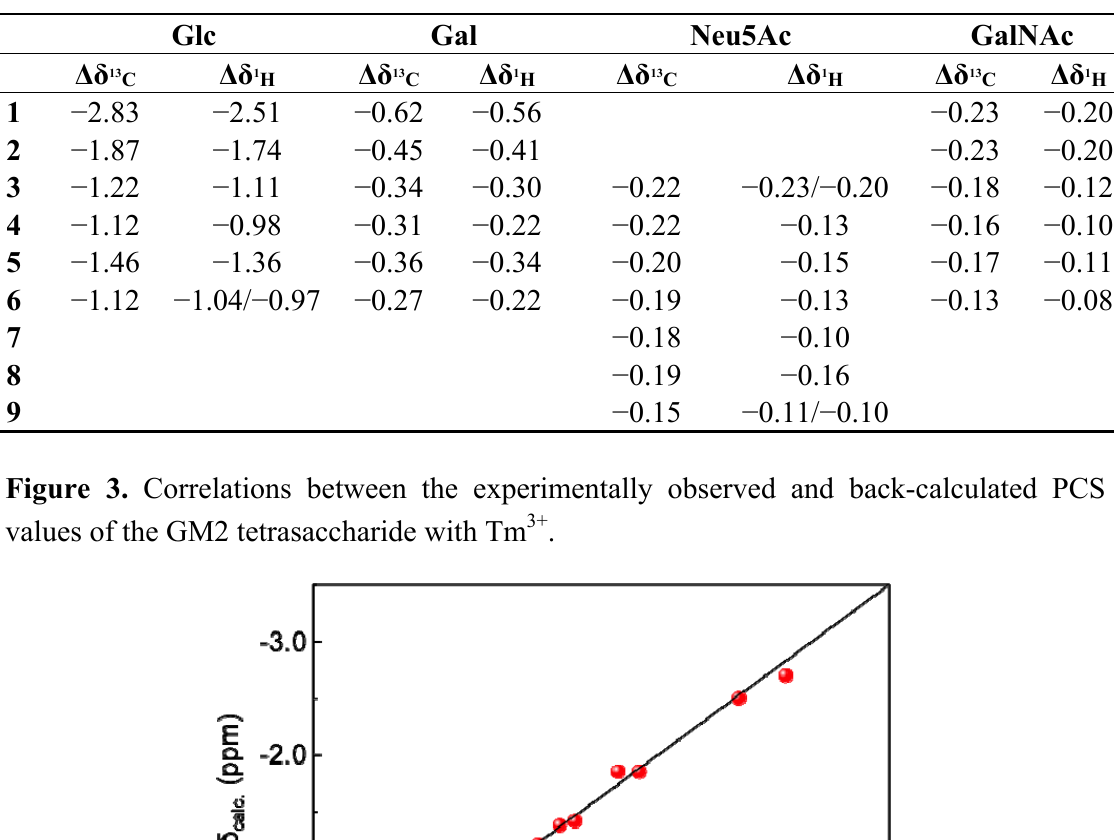
Table 2. PCS values (ppm) derived from the Tm 3+ ion.